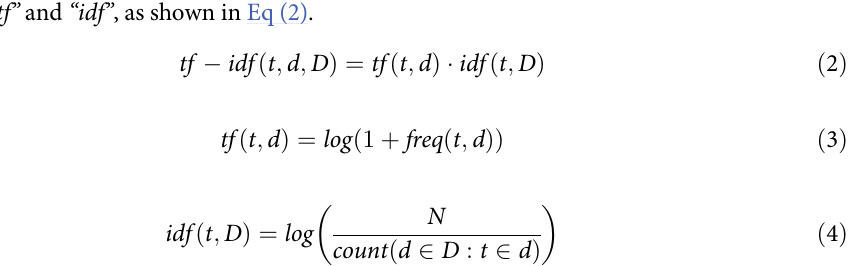
Fig 17. Example of pre-processed